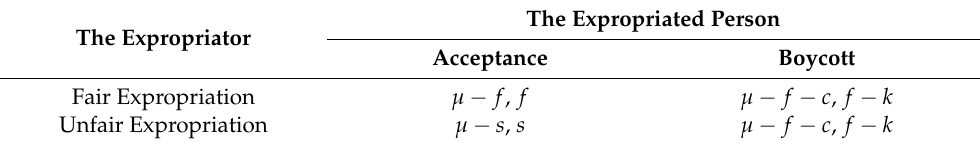
Table 1. The profit-seeking fairness game matrix of urban housing expropriation compensation. The